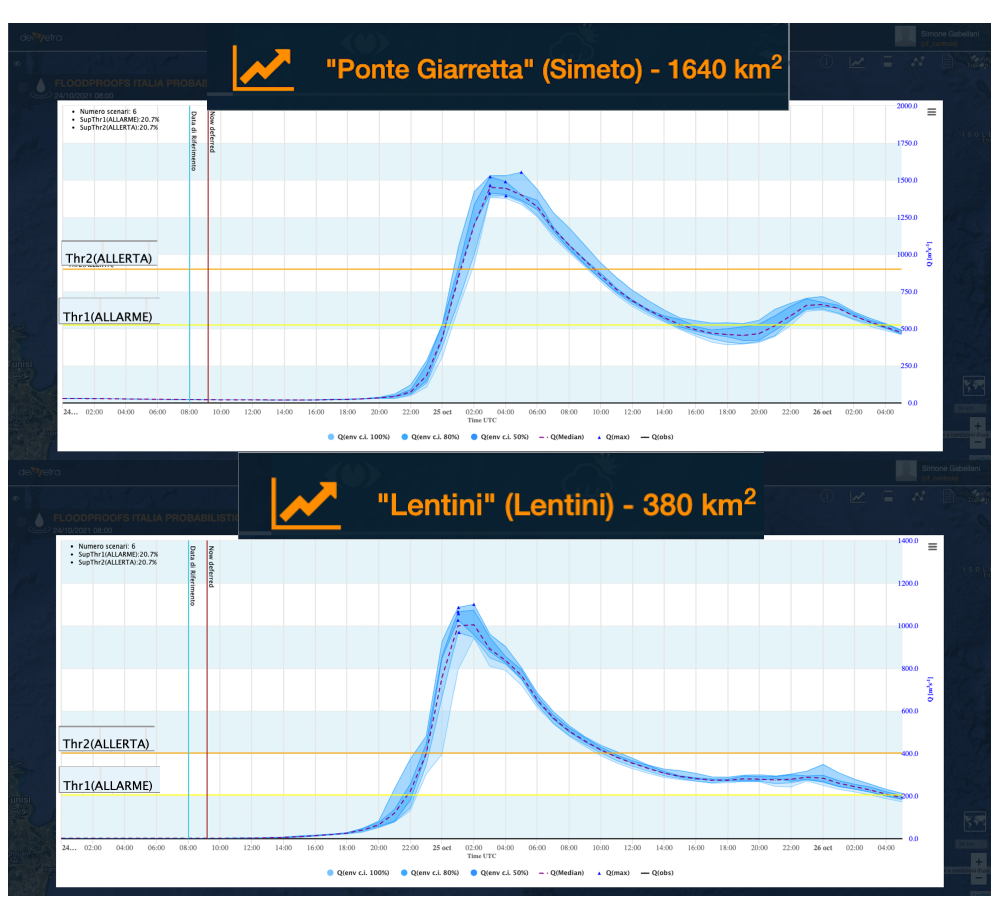
Figure 6. Hydrograph probabilistic forecast obtained by clicking on red sections represented in Figure 5 on MyDewetra platform Ponte Giaretta above and